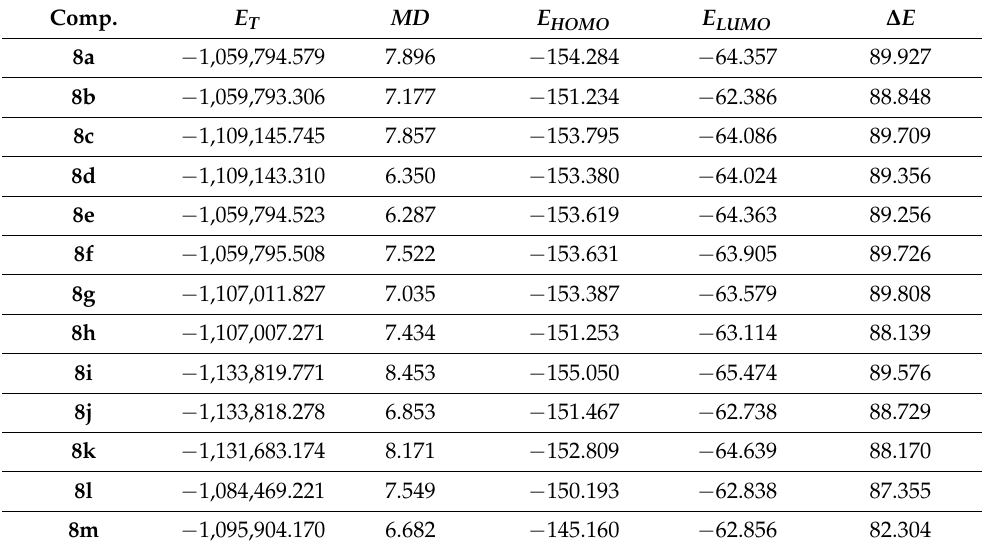
Table 2. Total energy E T (kcal/mol.), dipole moment M D (D), energy of HOMO, E HOMO , LUMO, E LUMO , orbitals (kcal/mol) and ∆ E = E LUMO − E HOMO (kcal/mol) for 8a – m calculated at the DFT/B3LYP/6-311++G(d,p) level. Comp. E T MD E HOMO E